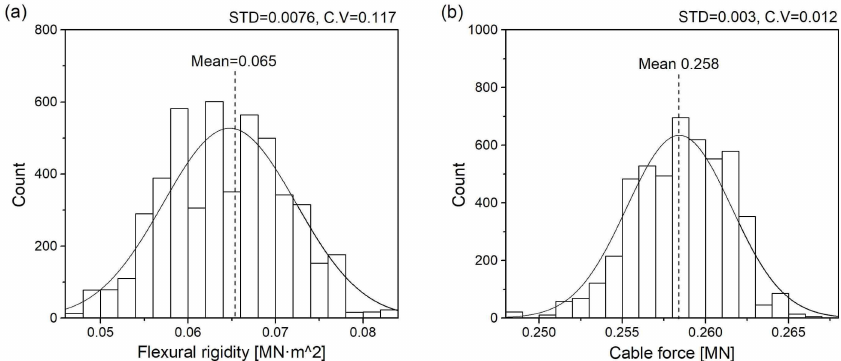
Figure 10. Histogram of the obtained samples of ( a ) flexural rigidity and ( b ) cable